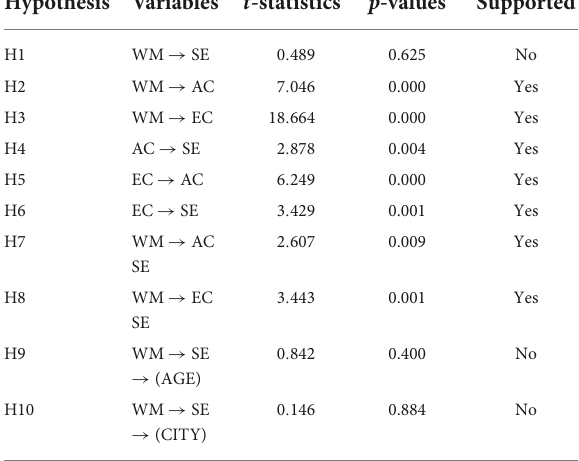
TABLE 4 Path coefficients